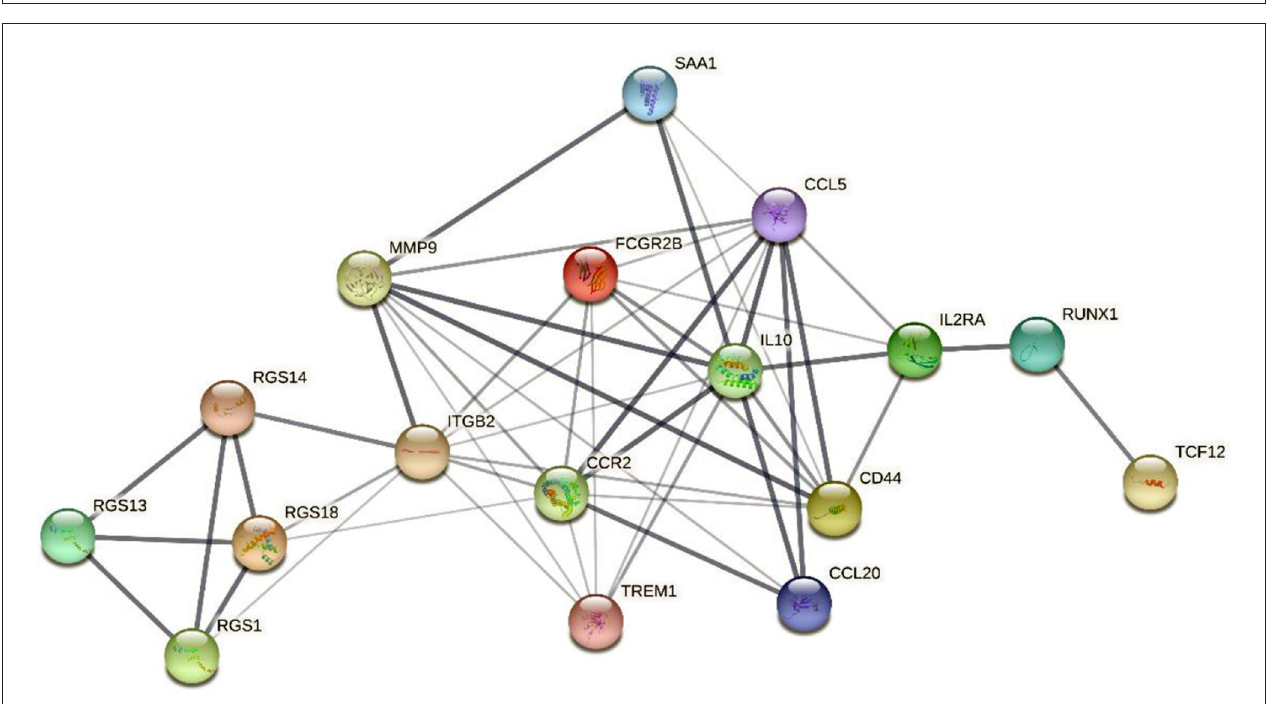
FIGURE 8 | The results of functional enrichment analysis of 198 DEIRGs. (A) The results of GO analysis demonstrated the most-enriched biological functions. (B) The results of KEGG analysis show the most enriched biological processes. The X-axis represents the enrichment fraction, while the Y-axis represents the GO term and the KEGG pathway. The color indicates the P -value, while the circle size of the bubble chart represents the gene counts.